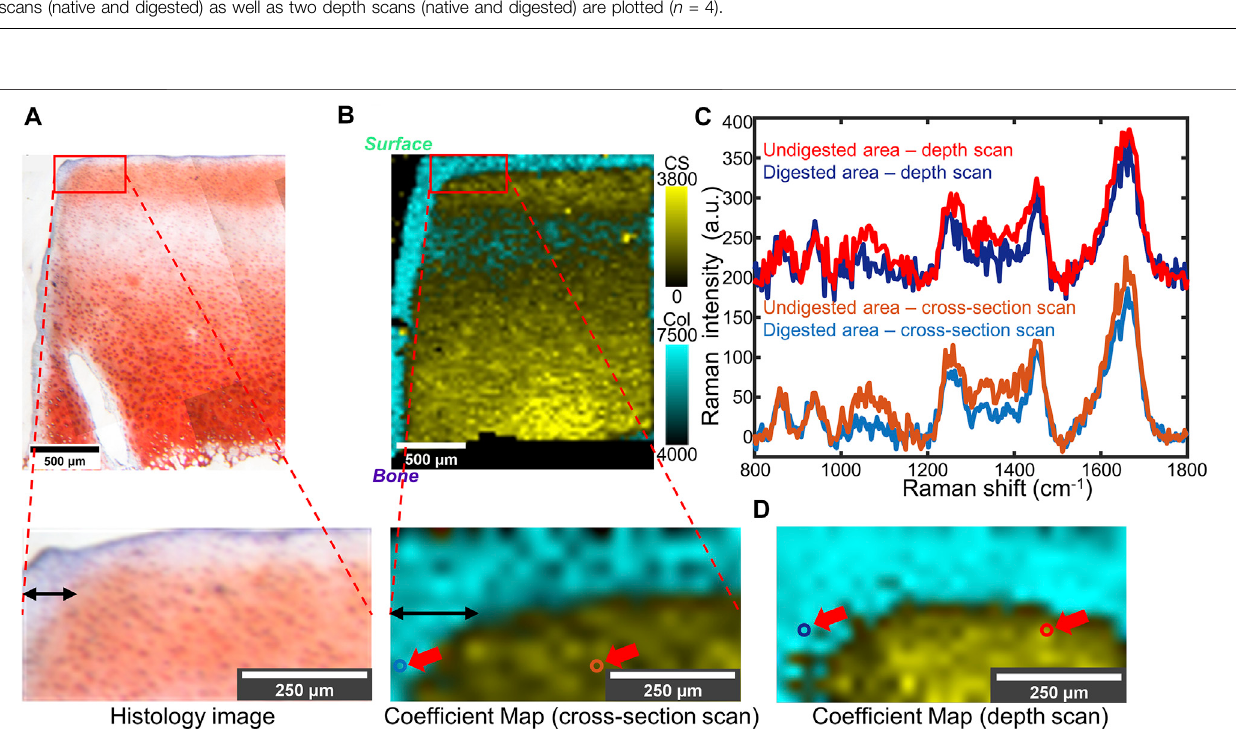
FIGURE4|(A) Top:Lightmicroscopeimageofpartiallytrypsin-digestedcartilagetissuestainedbySafranin-O.Bottom:Higher-magni fi cationoftheareaofinterest (the redbox). (B) Top:Overlaidcoef fi cient mapofCSandcollagentookinthesame regionas (A) ,takenbycross-sectionscan.Bottom:Highermagni fi cation ofthearea of interest (the red box). (C) Point spectra collected from digested or undigested areas ofthe same sample. Thecollectionpoints are shown as colored circles (indicated byredarrows)in( B ,bottom)and (D) .A200a.u.offsetwasappliedtoeachdepthscanspectrumforclarity. (D) Overlaidcoef fi cientmapofthesamesampleas (B) , taken by depth scan. In (B) and (D) : Cyan: collagen; Yellow: